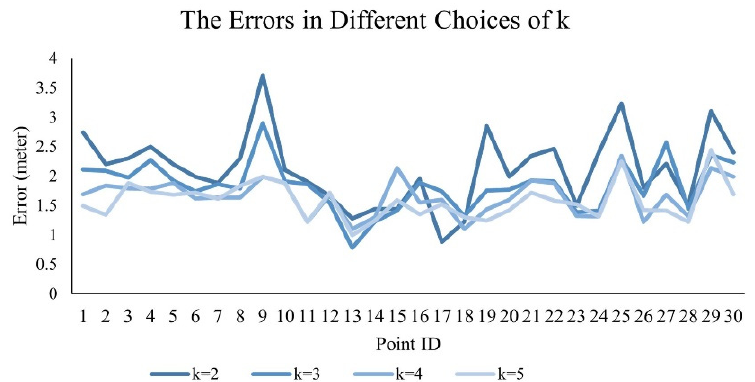
Figure 8. At each point, the tested errors were averaged. The y-axis is the average error.